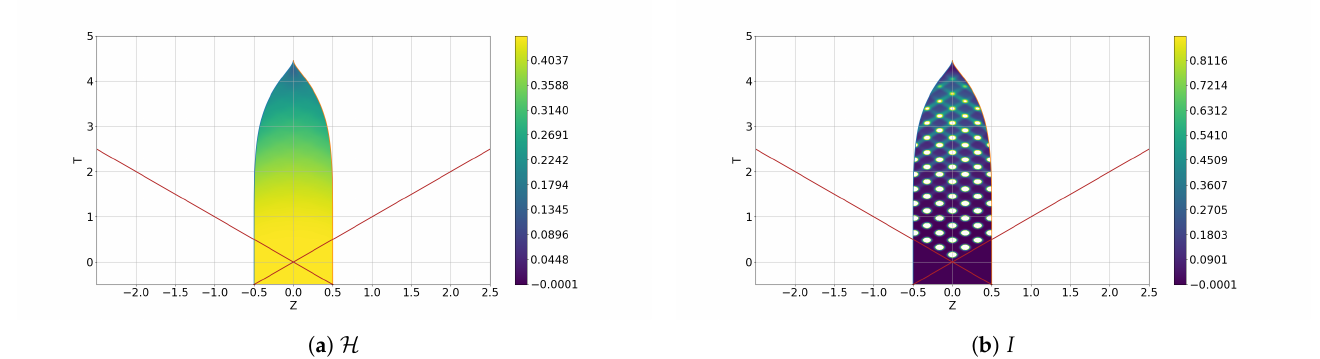
Figure 18. Our expansion rate H and the Weyl invariant I where boundary conditions were chosen using Equation (32) and with λ =